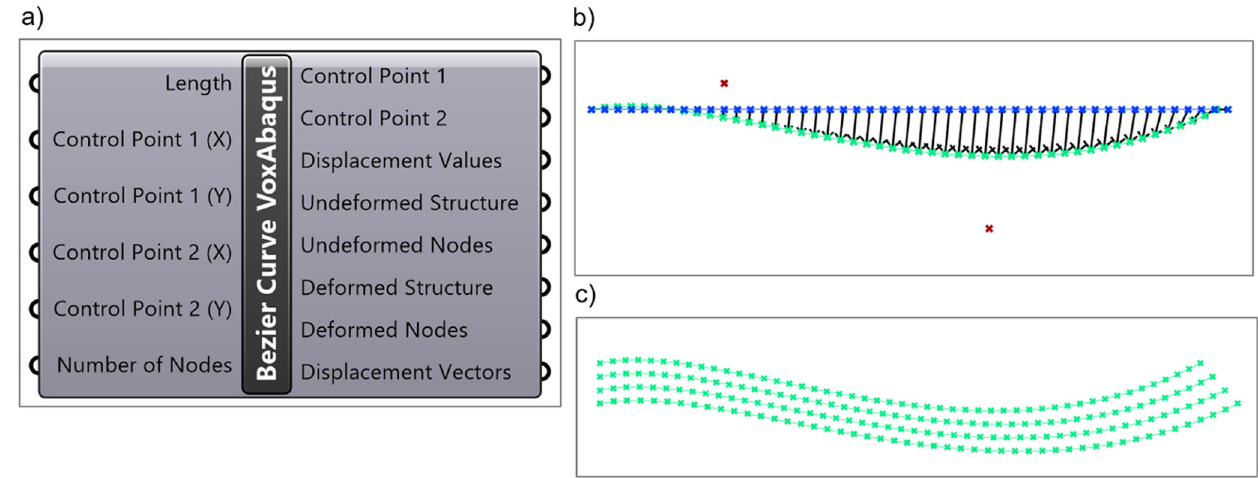
Fig. 9 Implementation in a computer-aided design system. ( a ) The component in GH used to generate and control the Bezier curves. ( b ) The generated Bezier curve (undeformed structure in blue, deformed structure in green, control points in red, displacement vectors in black). ( c ) The curve is stacked to provide a 2D representation.